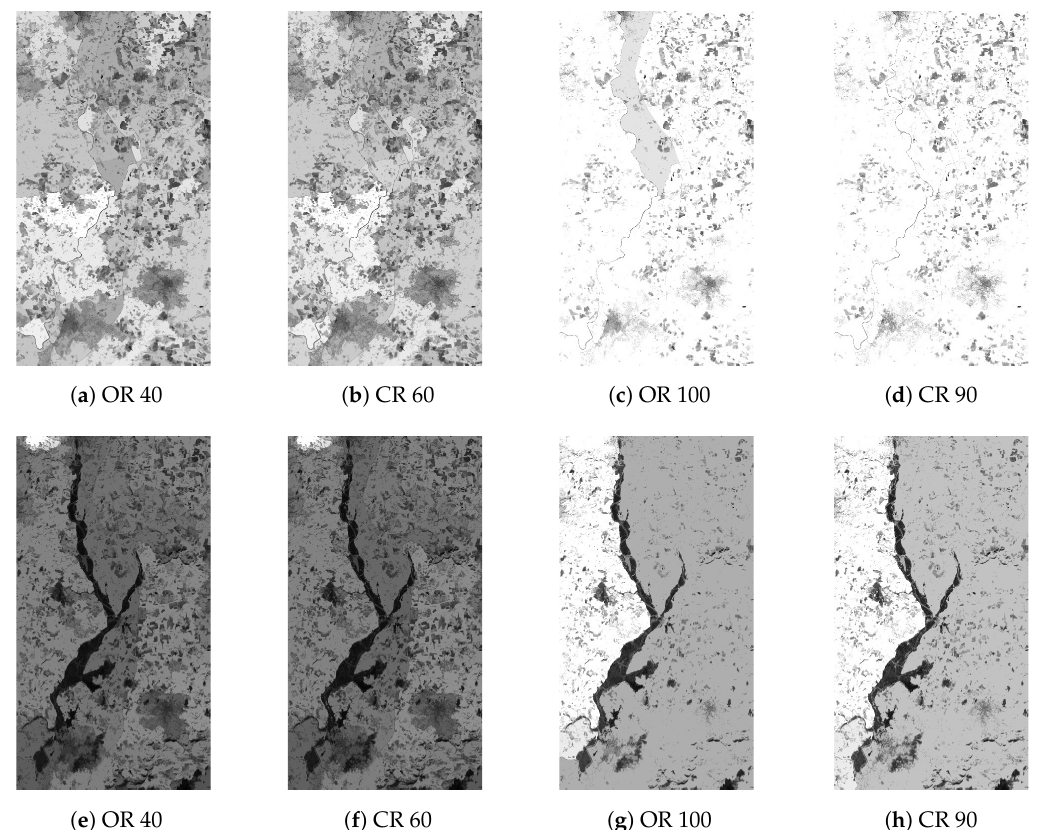
Figure 3. Derived morphological bands based on the pre-event (1st row) and post-event (2nd row) SPOT-5 image’s NIR band. CR: Closing by Reconstruction. OR: Opening by